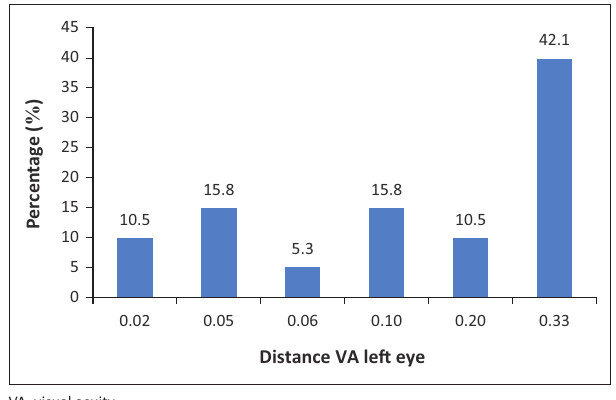
FIGURE 2: Distance visual acuity of the left eye recorded in decimal notation.